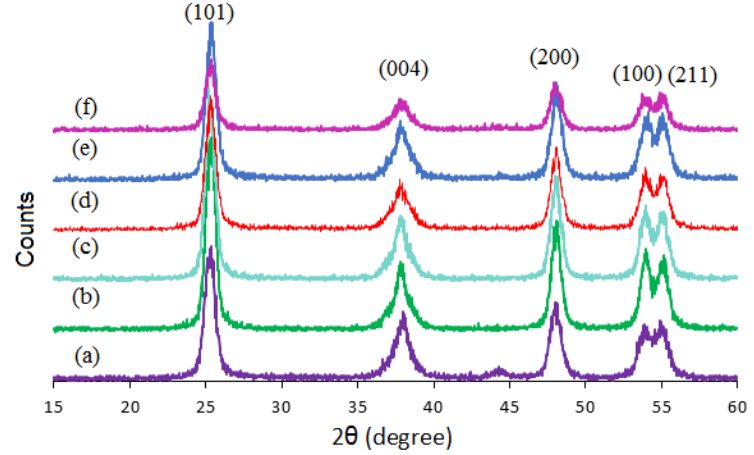
Fig. 1. XRD patterns of a) TiO TiO